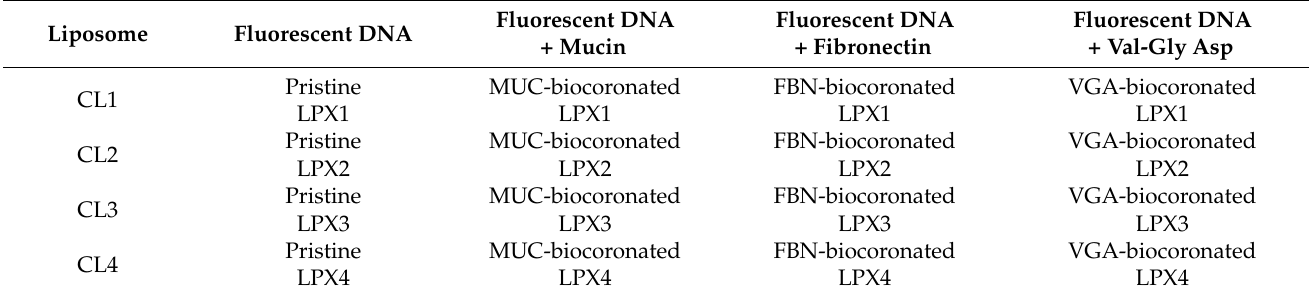
Table 1. Schematic representation of the obtained liposome, pristine lipoplexes (LPX) and biocoronated LPXs.